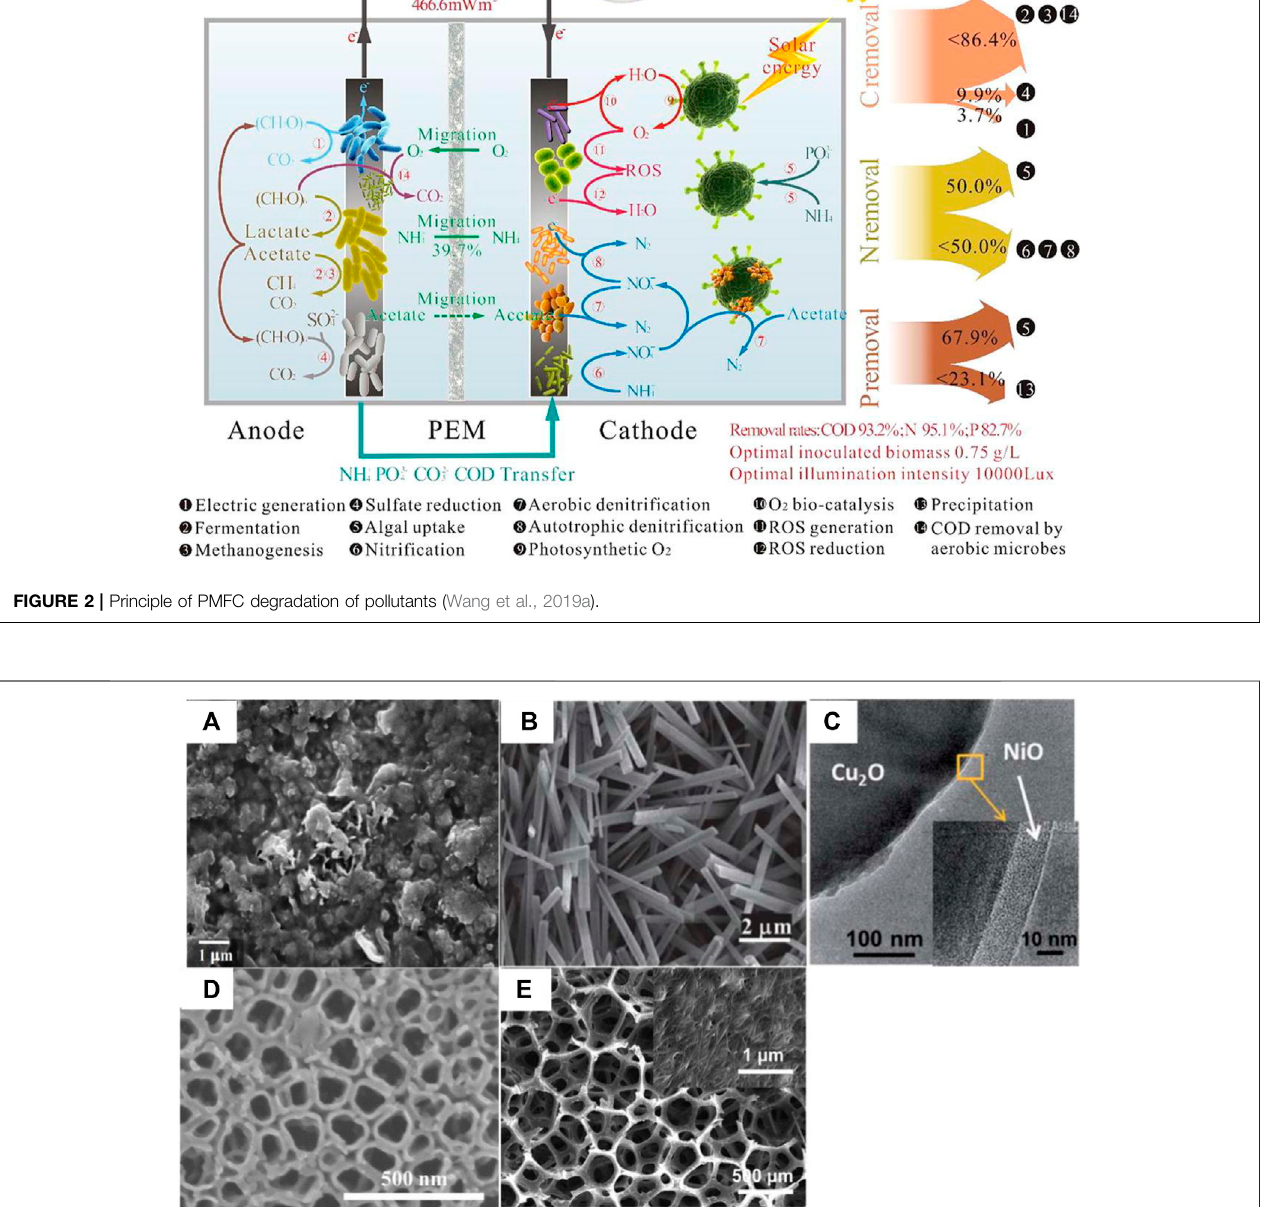
Frontiers in Chemistry |